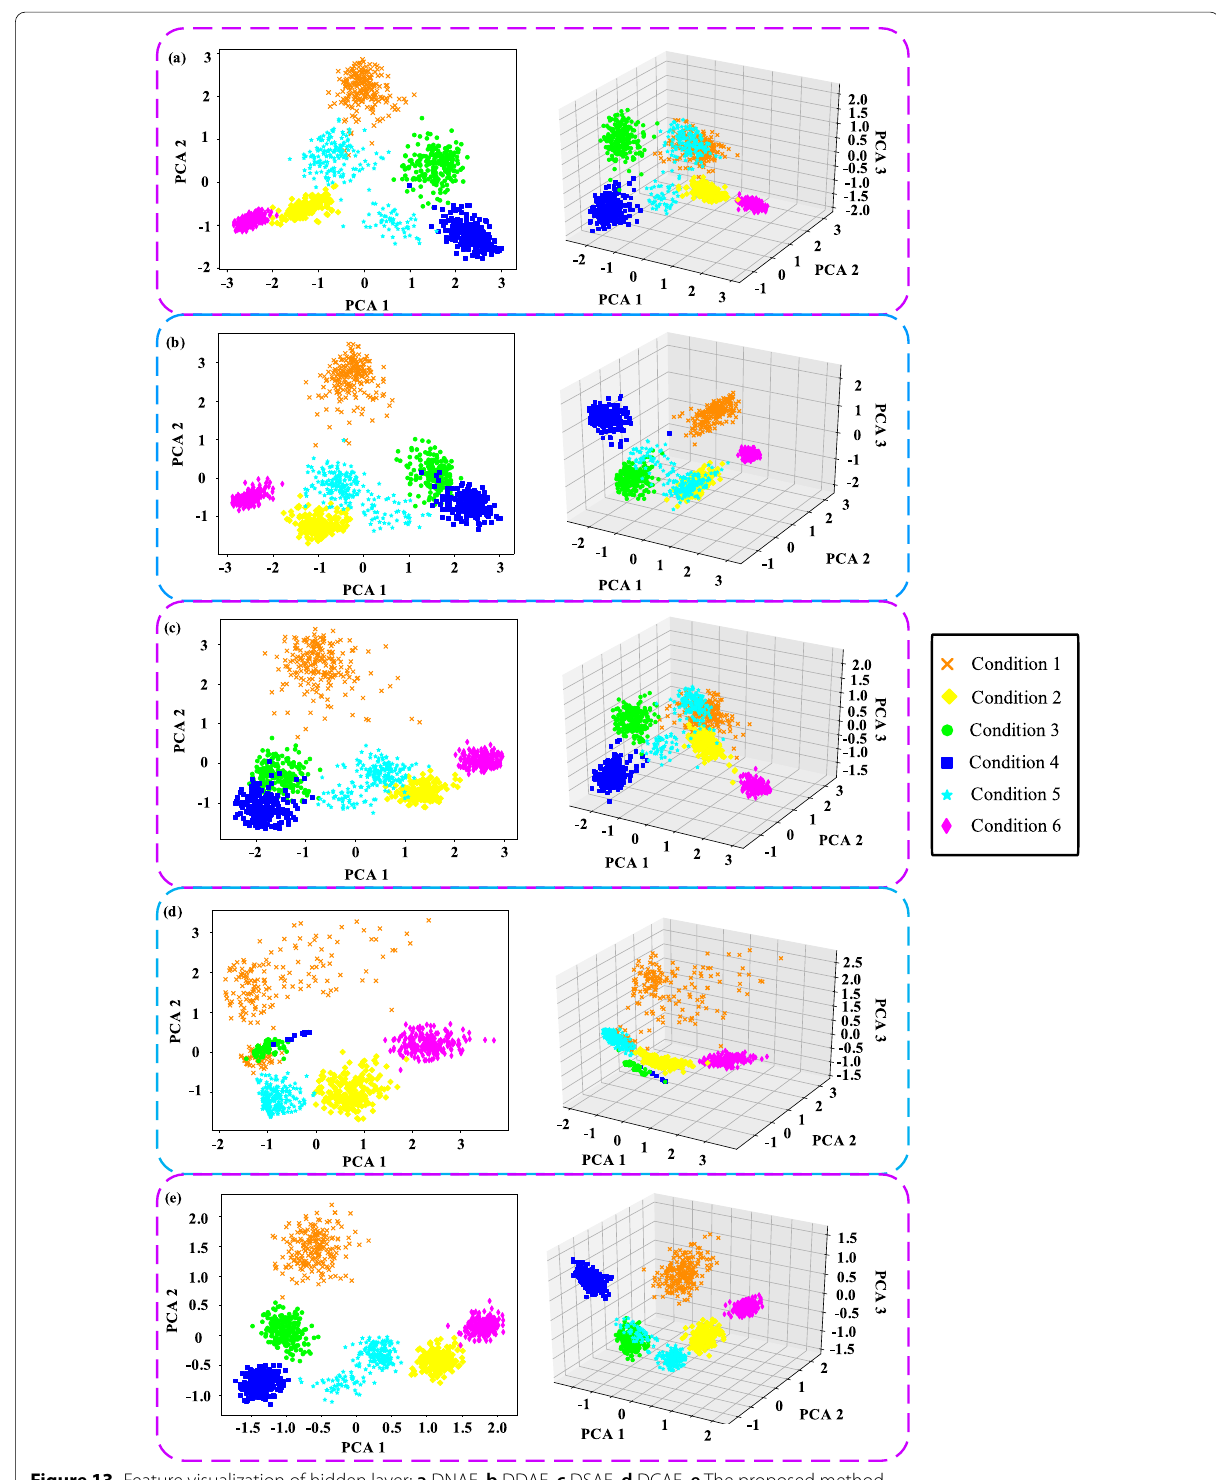
Figure 13 Feature visualization of hidden layer: a DNAE, b DDAE, c DSAE, d DCAE, e The proposed